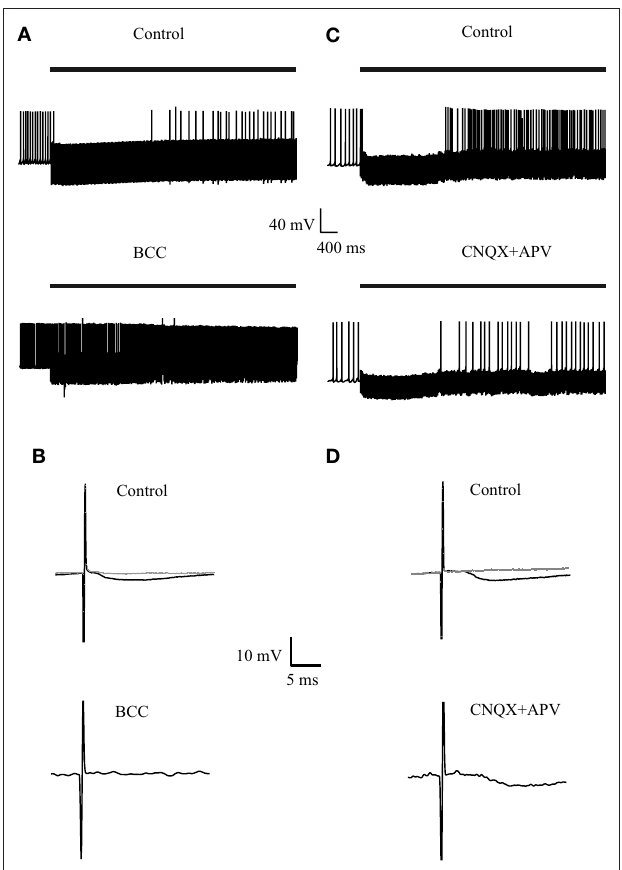
Figure 5 | effect of gABAergic and glutamatergic antagonists on the membrane potential during stimulation at 40 Hz. (A,C) Continuous recording of the membrane potential before (top trace) and after (bottom trace) application of (A) 50 μM bicuculline or (C) 15 μM CNQX and 50 μM APV, during the stimulation. The bold horizontal lines indicate the period of repetitive stimulation. (B,D) Representative responses of the membrane potential to a single before (top) and after (bottom) application of (B) 50 μM bicuculline or (D) 15 μM CNQX and 50 μM APV, during the stimulation. The black traces were from 100 ms following the onset of the stimulus train. The gray traces were from 1 s following the onset of the stimulus train.